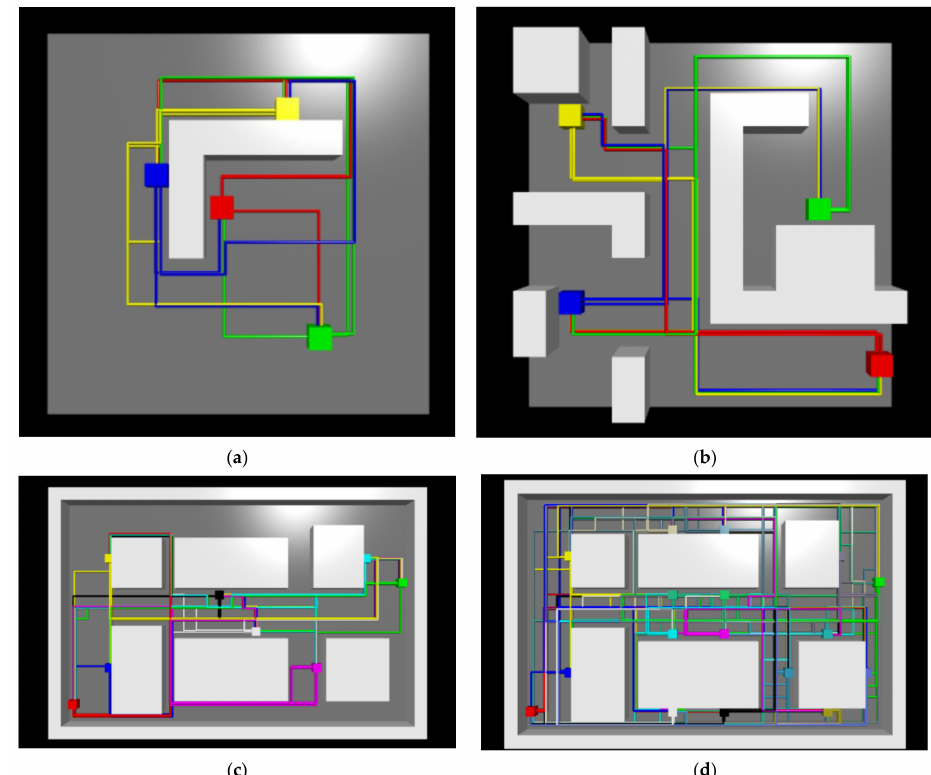
Figure 11. Results on different layouts: ( a ) four pick-up/drop-off locations, one wall, 12 × 12 m; ( b ) four pick-up/drop-off locations, multiple walls, 12 × 12 m; ( c ) eight pick-up/drop-off locations, 30 × 20 m; and ( d ) seventeen pick-up/drop-off locations, 30 × 20 m. The coloured squares (blue, red, green, and yellow, etc.) indicate pick-up/drop-off locations, the colour of the route indicates which pick-up location the route belongs to, the walls/obstacles are represented in light grey, and the driving surface is coloured dark grey.